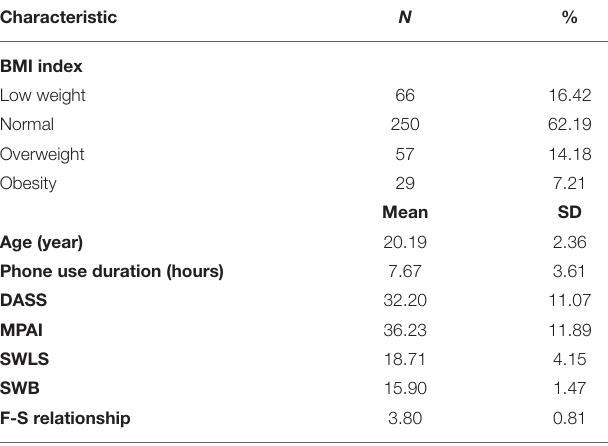
Univariate Analyses and Correlation